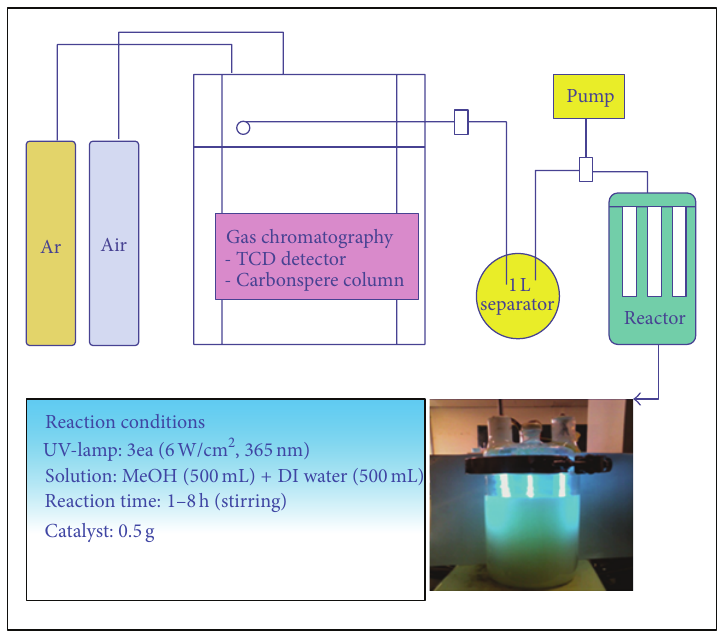
Figure 1: Liquid photoreactor designed in our laboratory for photosplitting in a MeOH/H 2 O solution.